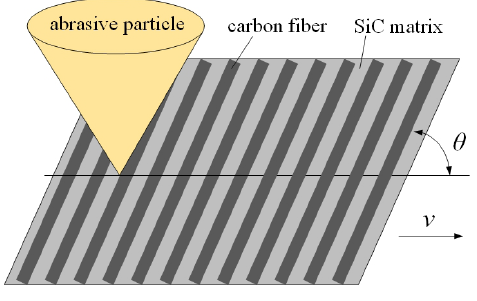
Figure 5. Diagram of a fiber orientation angle.